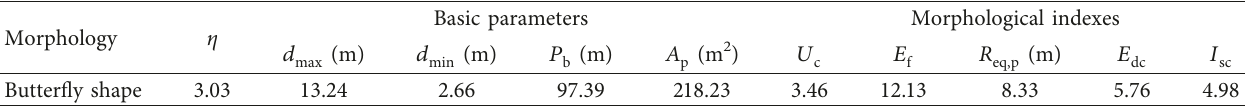
Table 1: Magnitudes of morphological indexes for the plastic zone. Basic parameters Morphological indexes Morphology η Butterfly